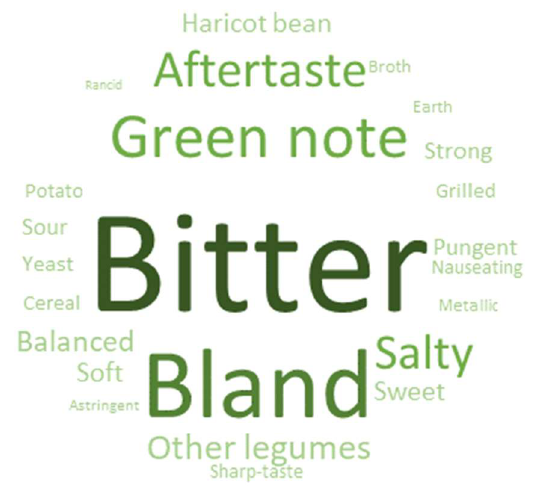
Figure 5. Word cloud based on the 24 perception classes that explained the hedonic score of the 12 gels. 12